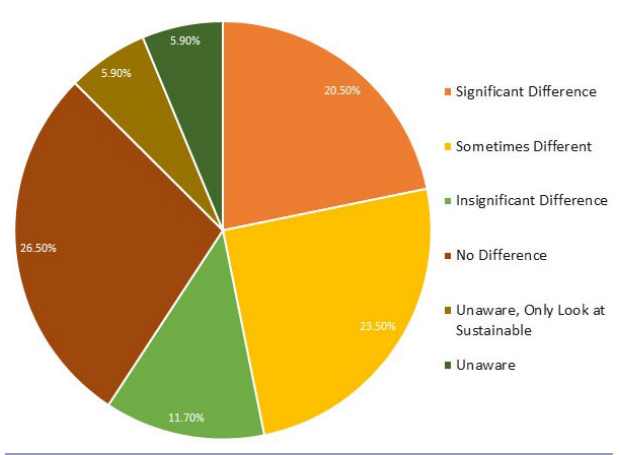
Fig. 4 . Price premium between Ocean Wise and non-Ocean Wise seafood items.